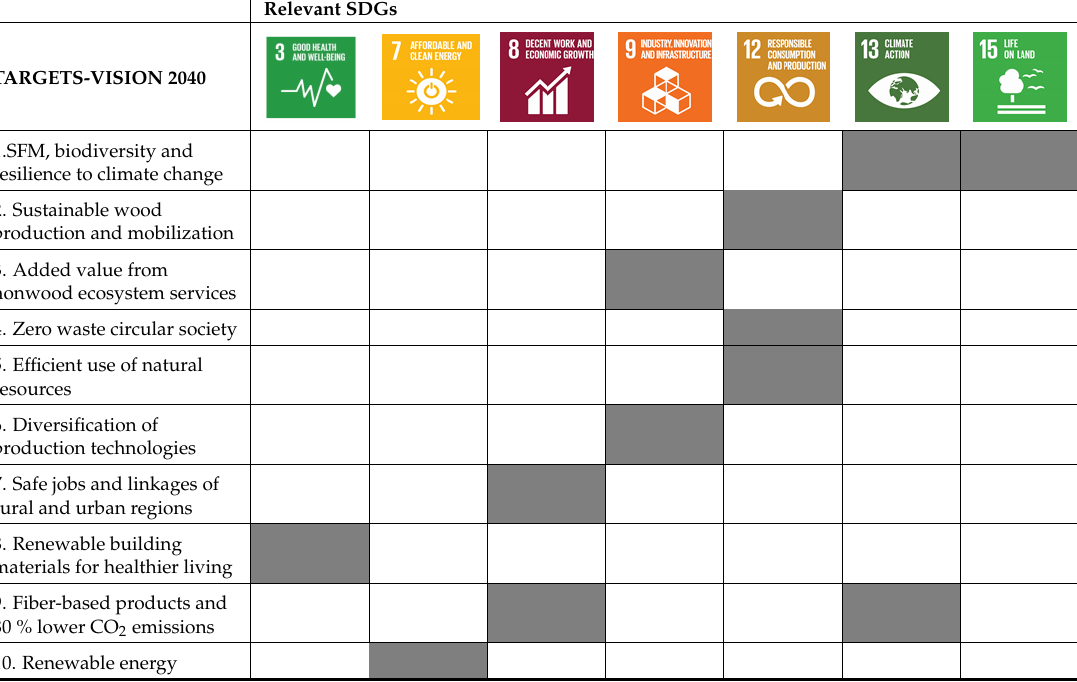
Table 2. The synergies between the European forestry-based sector (Vision 2040) targets and their relevant SDGs